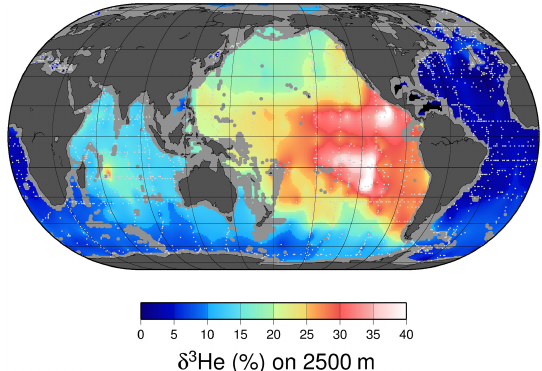
Figure 8. A map of δ 3 He values at approximately 2500m depth. The values plotted are simply an average of all measurements within a 1 ◦ square between 2250 and 2750dbar. Depths shallower than 2500m are masked in gray, and sampling locations are indicated by light gray dots.